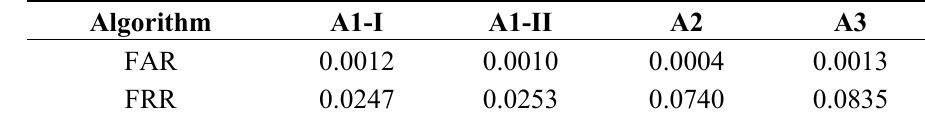
Table 6. Best performance (operation points closest to the performance target FRR ≤ 0.01 @ FAR = 0.001)—multi-instance (left and right index fingers) fusion.